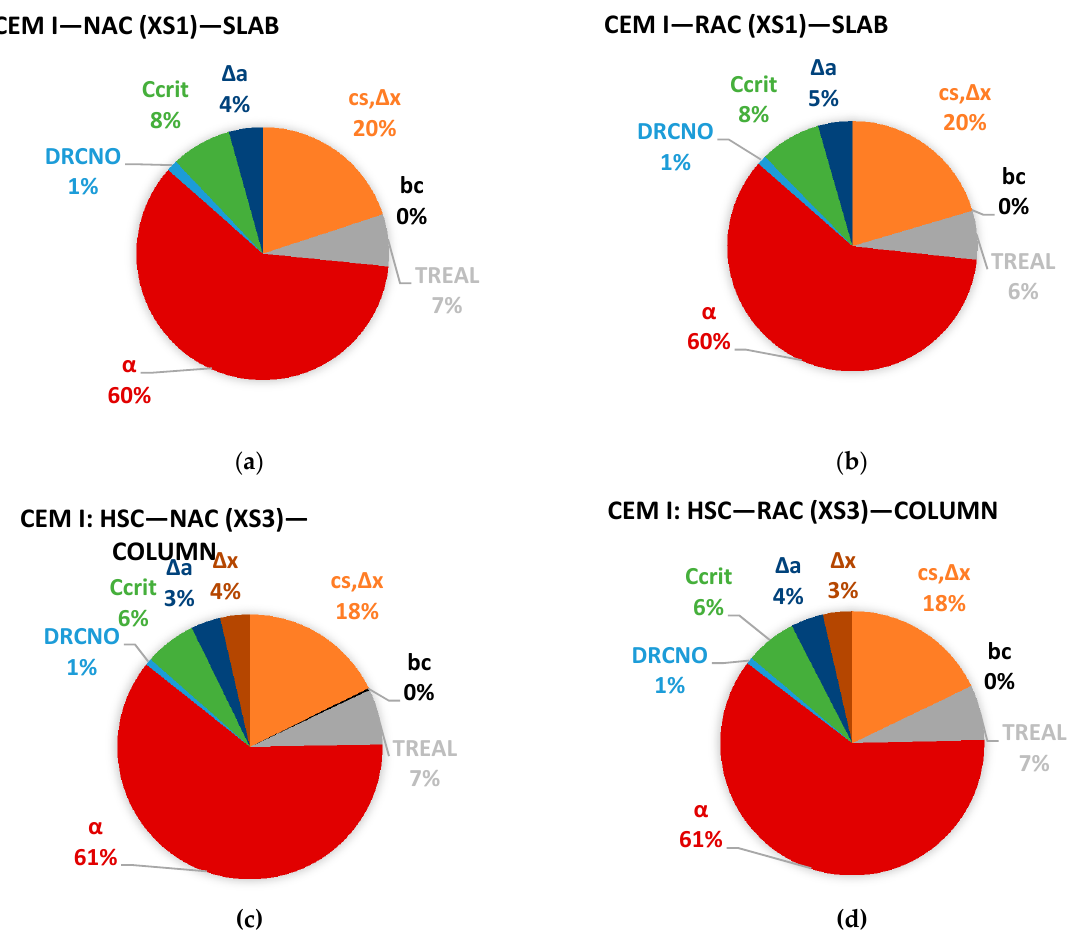
Figure 7. α 2 of four cases of design: ( a ) CEM I—NAC, XS1, and slab; ( b ) CEM I: RAC, XS1, and slab; ( c ) CEM I: HSC—NAC, XS3, and column; ( d ) CEM I: HSC—RAC, XS3, and column